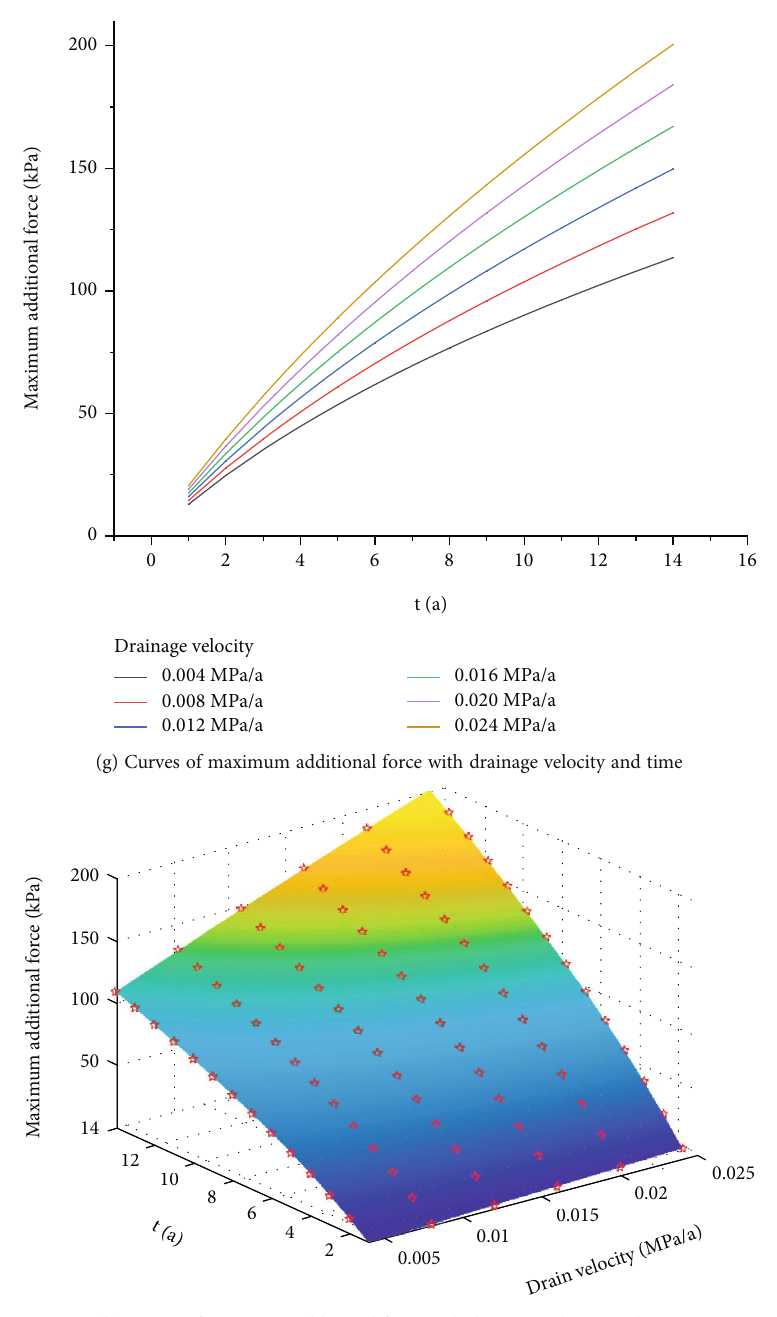
Figure 14: Relationship between the additional force and drainage